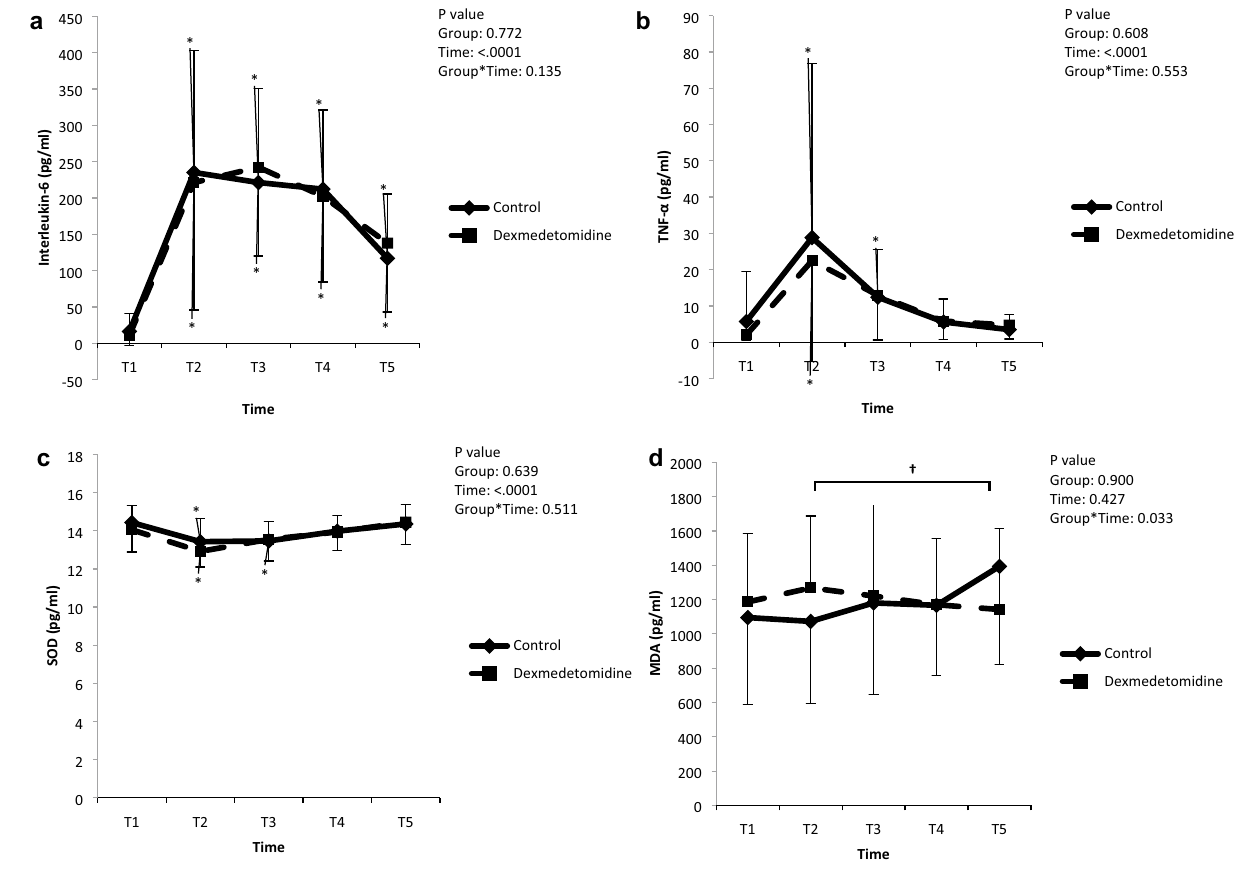
Figure 3. Changes in the levels of biomarkers. TNF, tumor necrosis factor; SOD, superoxide dismutase; MDA, malondialdehyde; T1, post-induction; T2, ACC 1 h; T3, ACC 6 h; T4, ACC 12 h; T5, ACC 24 h. * P < 0.05 versus baseline; † time-group